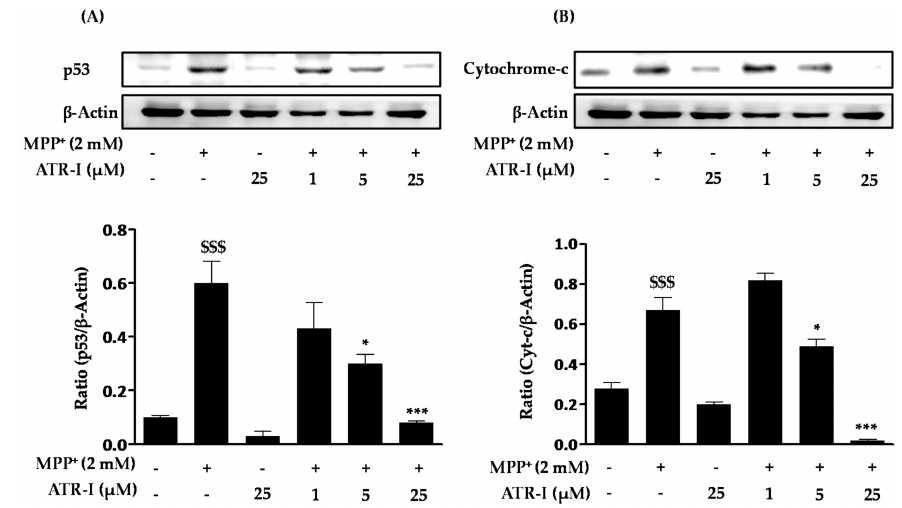
Figure 3. Effect of ATR-I on the MPP + -induced p53 and cytochrome-c release in SH-SY5Y cells. SH-SY5Y cells were subjected to Western blotting with specific antibodies for p53 ( A ) and cytochrome-c ( B ). Quantification of the relative expression of p53 and cytochrome-c is provided in the bar graph. β -actin was used as an internal control. $$$ p < 0.001 vs. the vehicle group; *** p < 0.001 and * p < 0.05 vs. the MPP + -treated